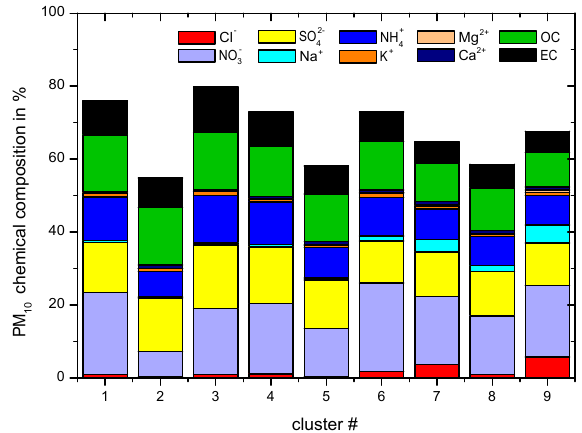
Fig. 10. Chemical composition of PM 10 in the rural background during each cluster. The amount missing to 100% is inaccessible to the chemical analyses performed and interpreted as insoluble crustal